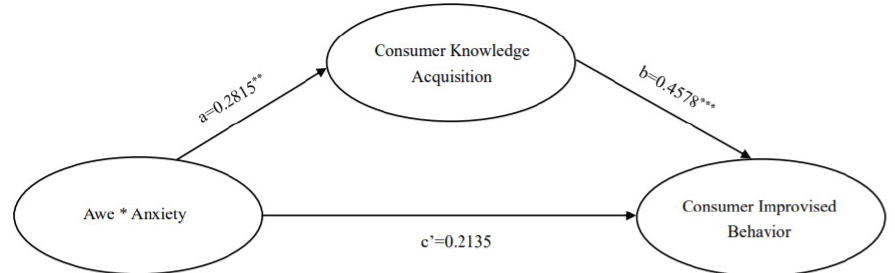
Figure 4. Results of the analysis of mediating effects of consumer knowledge ac-quisition (Looseness culture). Note: Awe * Anxiety represents the interaction of the two variables of awe and anxiety; ** indicates p < 0.01; *** indicates p < 0.001.